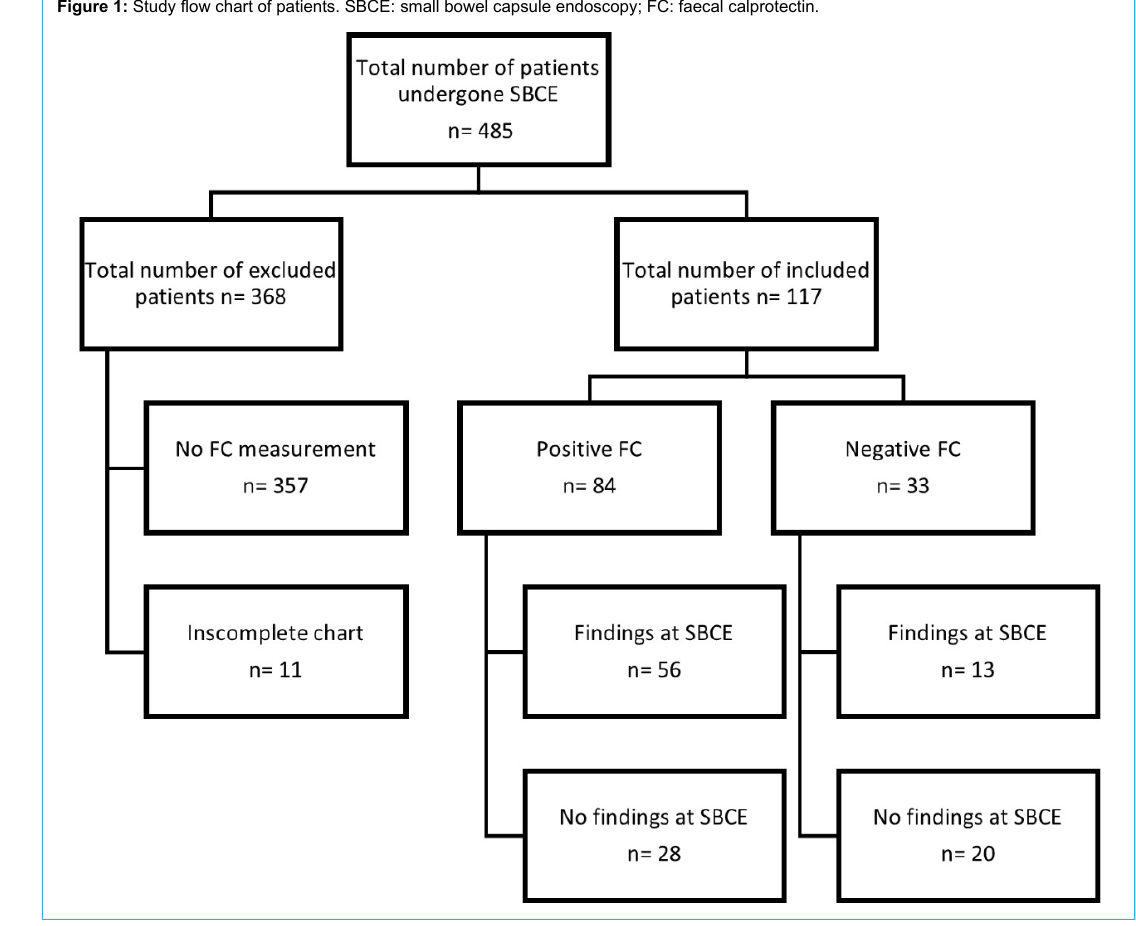
Figure 1: Study flow chart of patients. SBCE: small bowel capsule endoscopy; FC: faecal